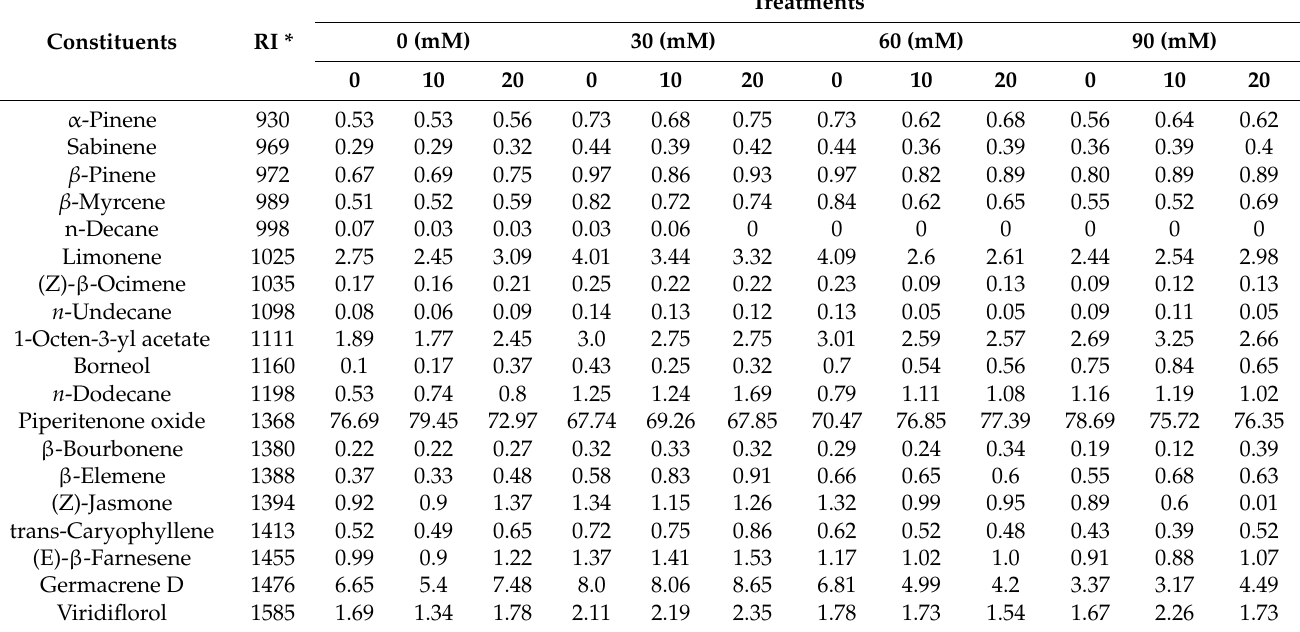
Table 3. Amount of pineapple mint essential oil compounds under different levels of salinity and foliar application of